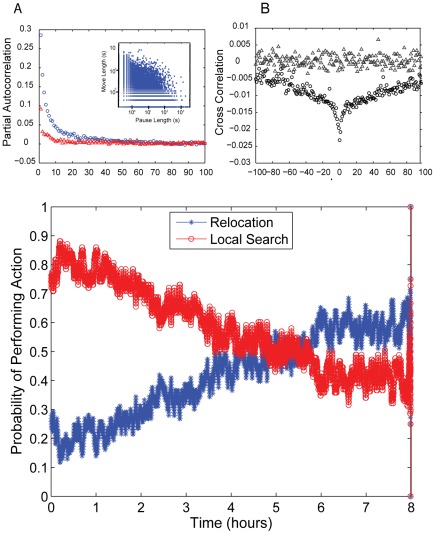
Correlation analysis for moves and pauses and behavioural modes.Partial autocorrelation analysis results (A) for moves, blue circles, and pauses, red triangles, reveals that moves are positively correlated and pauses show a slight positive, if any, correlation, therefore moves show much stronger local correlations than pauses. Inset shows first order correlation between moves and pauses (see Figure S6). A cross correlation of moves and pauses (B) shows a high negative correlation at a local scale, circles, which persists for larger time scales. The shuffled data are also shown (triangles) for comparison. (C) shows the probability that a locust performs two different behaviours (local search and relocation) over the course of the 8 hr experiment. Relocation behaviour (blue asterisks) is defined as long moves preceded or followed by short pauses. Local search behaviour (red circles) is defined as long pauses preceded or followed by short moves. Behavioural modes are classified using the Partial Sums algorithm with a minimum time threshold of 5 min.